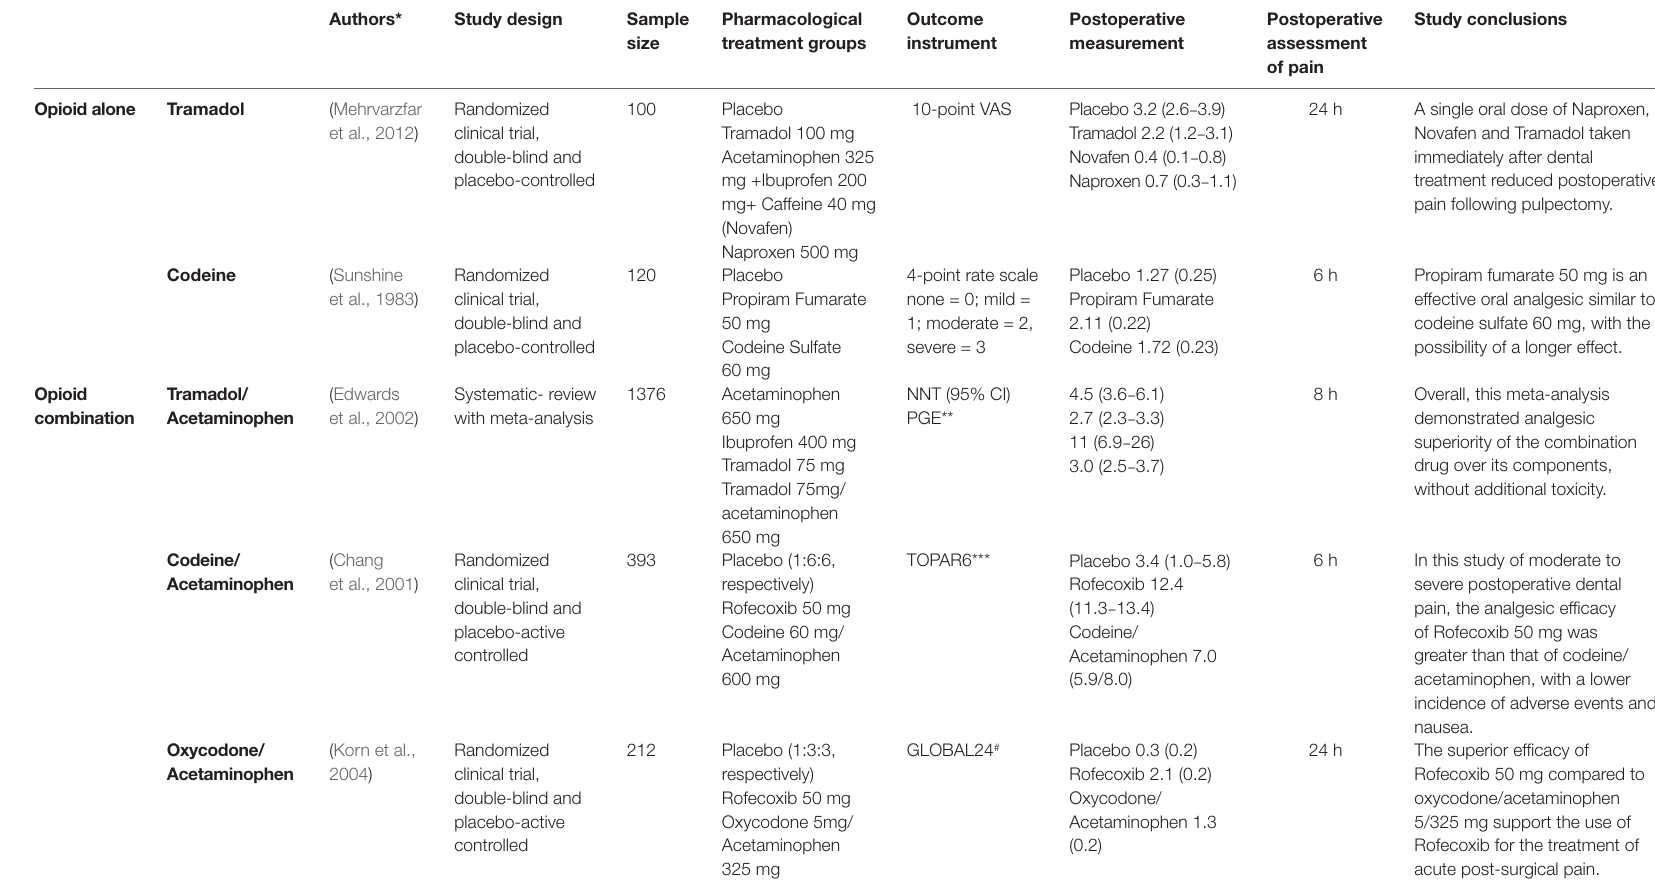
TABLE 1 | Pharmacological treatment possibilities to control post-operative pain in dentistry with opioids alone and in different